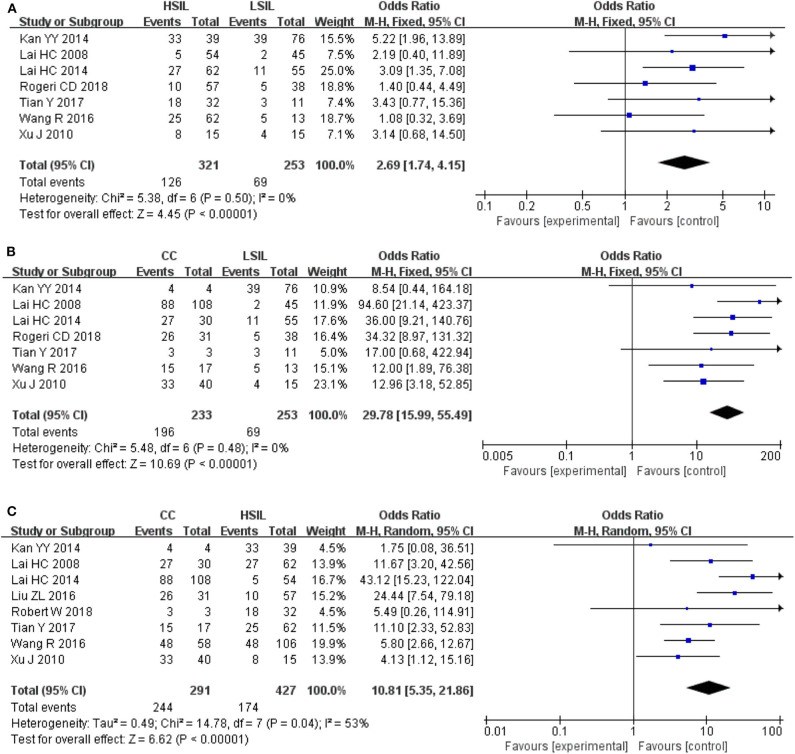
(A) Forest plots for associations of SOX1 promoter hypermethylation with the risk of HSIL compared with LSIL; (B) Forest plots for associations of SOX1 promoter hypermethylation with the risk of LSIL compared with cervical cancer; (C) Forest plots for associations of SOX1 promoter hypermethylation with the risk of HSIL compared with cervical cancer. The squares represent the ORs for individual studies. The size of the square reflects the weight of included studies. Bars represent the 95% confidence intervals (CIs). The center of the diamond represents the summary effect size.